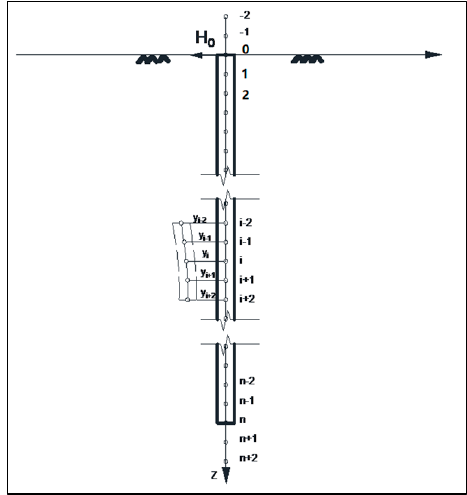
Figure 7. The single pile node division diagram.